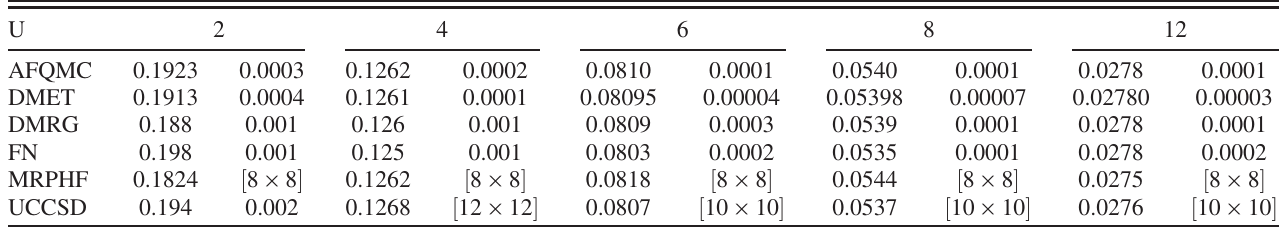
TABLE III. Zero-temperature double occupancy and uncertainty for n ¼ 1 , for a range of interaction strengths U , obtained from AFQMC, DMET, DMRG, FN, MRPHF, and UCCSD. Where extrapolations to the TL are not available, finite-size geometries are listed in lieu of